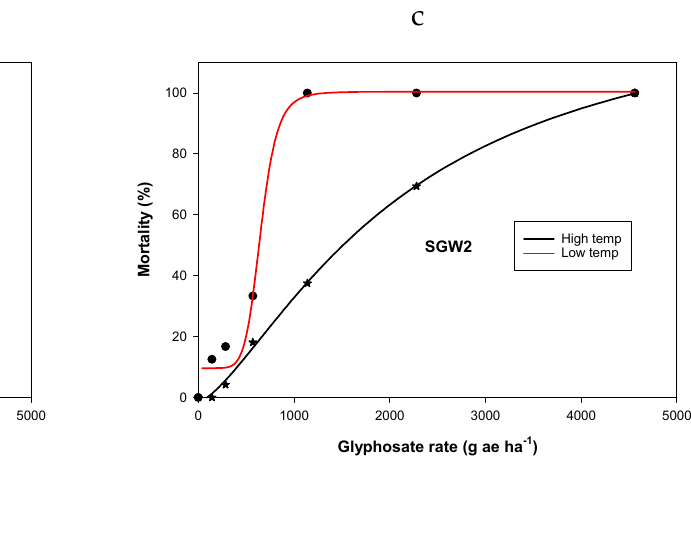
Figures in parentheses indicate the standard error of means (±); LT: Low temperature; HT: High temperature; y 0 = bottom of the curve; a = difference between the top and bottom of the curve; b = slope of the curve. * Values with different letters are significantly different at 5% level of significance on the basis of the t -test.